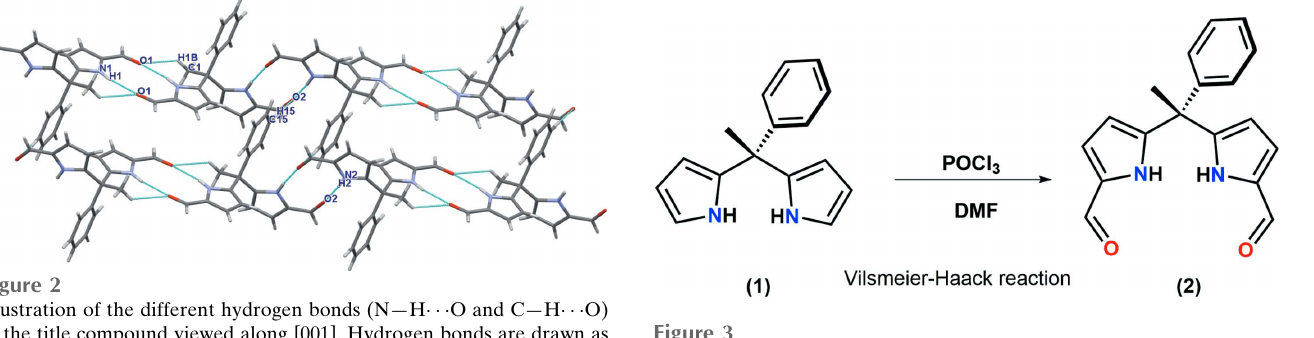
Figure 3 Reaction scheme.